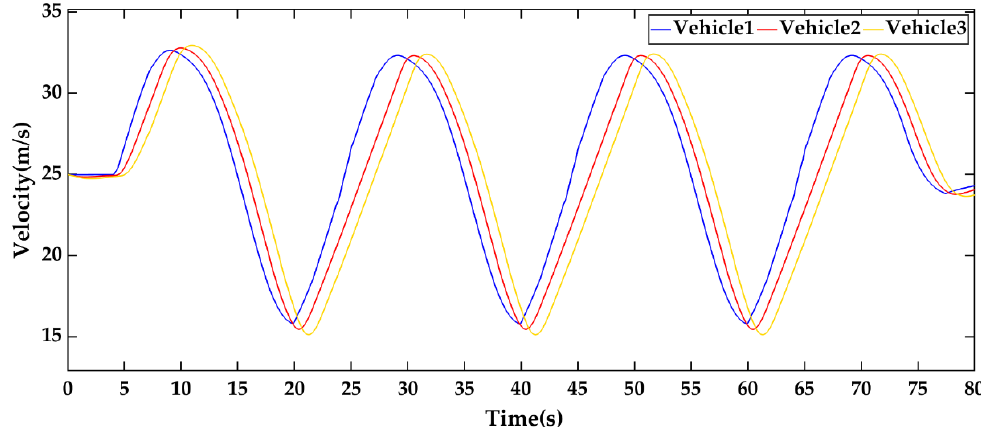
Figure 18. The velocities of the following vehicle under the improved MPC strategy in Scenario 2.